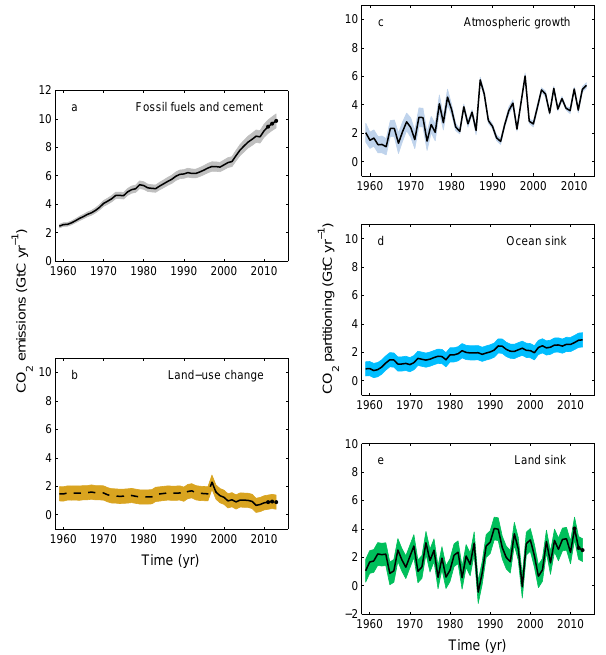
Figure 4. Components of the global carbon budget and their uncer- tainties as a function of time, presented individually for (a) emis- sions from fossil fuel combustion and cement production ( E FF ), (b) emissions from land-use change ( E LUC ), (c) atmospheric CO 2 growth rate ( G ATM ), (d) the ocean CO 2 sink ( S OCEAN ; positive in- dicates a flux from the atmosphere to the ocean), and (e) the land CO 2 sink ( S LAND ; positive indicates a flux from the atmosphere to the land). All time series are in GtC yr − 1 , with the uncertainty bounds representing ± 1 σ in shaded colour. Data sources are as in Fig. 2. The black dots in panels (a) , (b) , and (e) show values for 2011, 2012, and 2013 that originate from a different data set to the remainder of the data, as explained in the